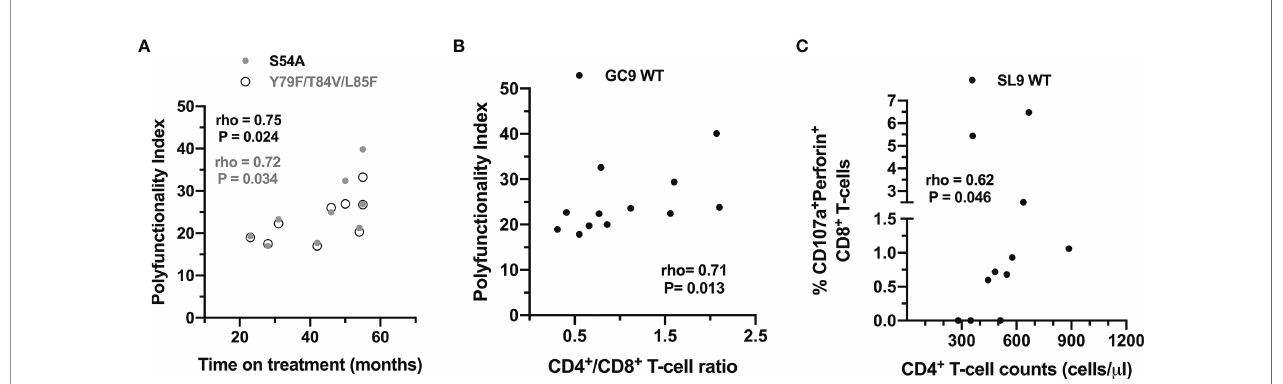
FIGURE 7 | Association between clinical variables and the CD8 + T-cell response to wild type and mutated peptides. (A) Correlation between the PI of CD8 + T-cells after stimulation with the S54A (black dots) and Y79F/T84V/L85F peptides (gray dots), and the time on treatment of the HIV-1-infected individuals. (B) Correlation between the PI of CD8 + T-cells after stimulation with the GC9 WT and CD4:CD8 ratio. (C) Correlation between the frequency of CD107a + perforin + CD8 + T-cells after stimulation with the SL9 WT and CD4 + T-cell counts. The rho and P-value of the Spearman test